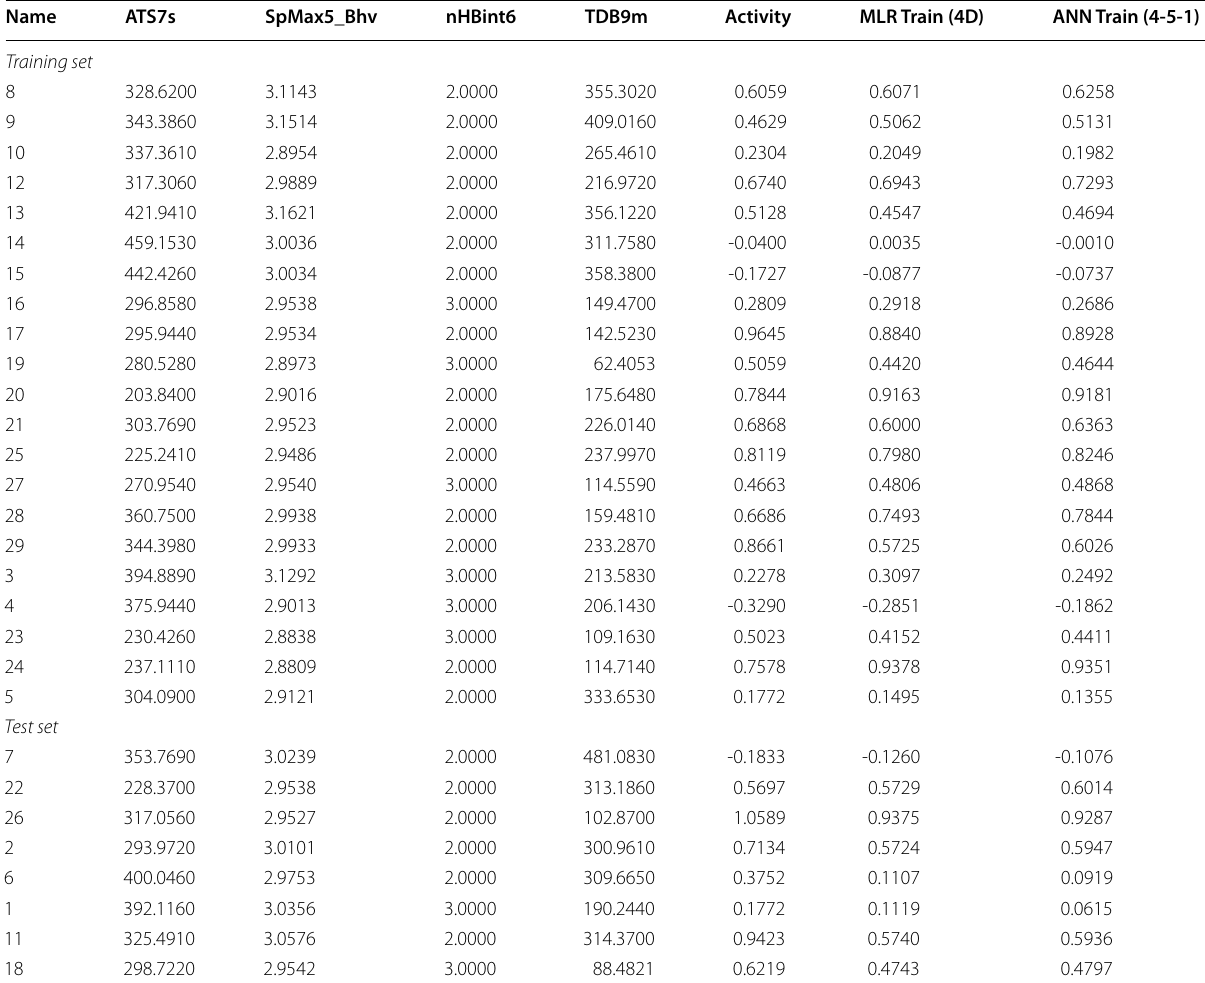
Table 7 Computed model descriptor values